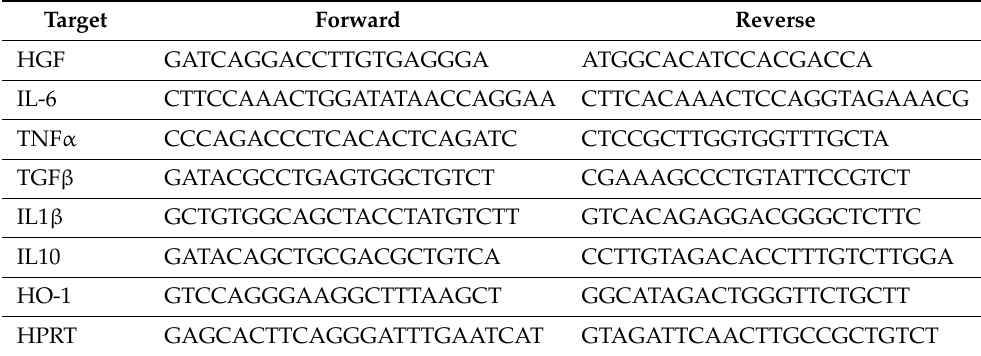
Table 1. Primers used for RT-qPCR